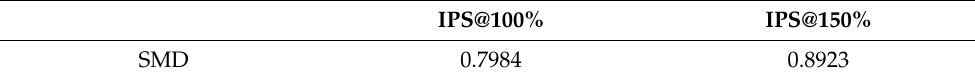
Table 3. Explanation of exceptions.